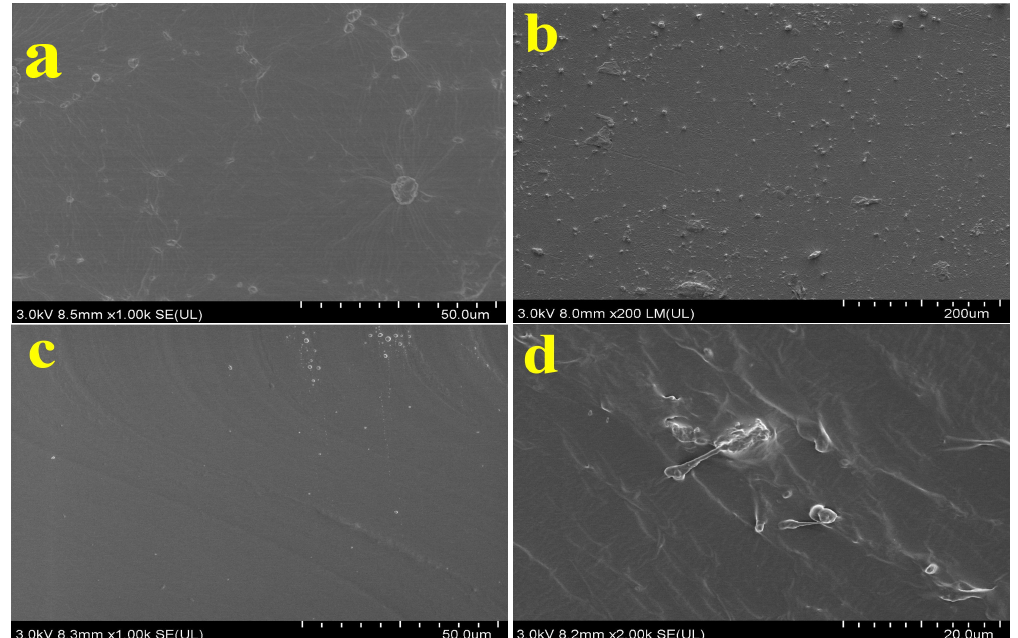
Figure 16. ( a ) SEM surface morphology of PDMS composite without fluorescent powder and the average size of about 50 µ m, ( b ) SEM surface morphology of PDMS composite with fluorescent powder and the average size of about 200 µ m ( c ) SEM sectional morphology of PDMS composite without fluorescent powder and the average size of about 50 µ m, ( d ) SEM sectional morphology of PDMS composite with fluorescent powder and the average size of about 20 µ